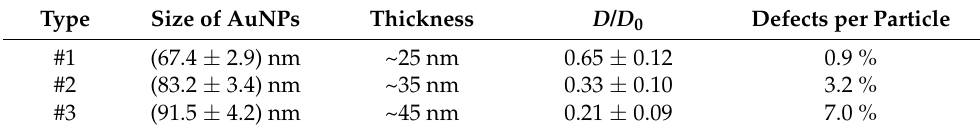
Table 1. Distribution parameters of AuNP